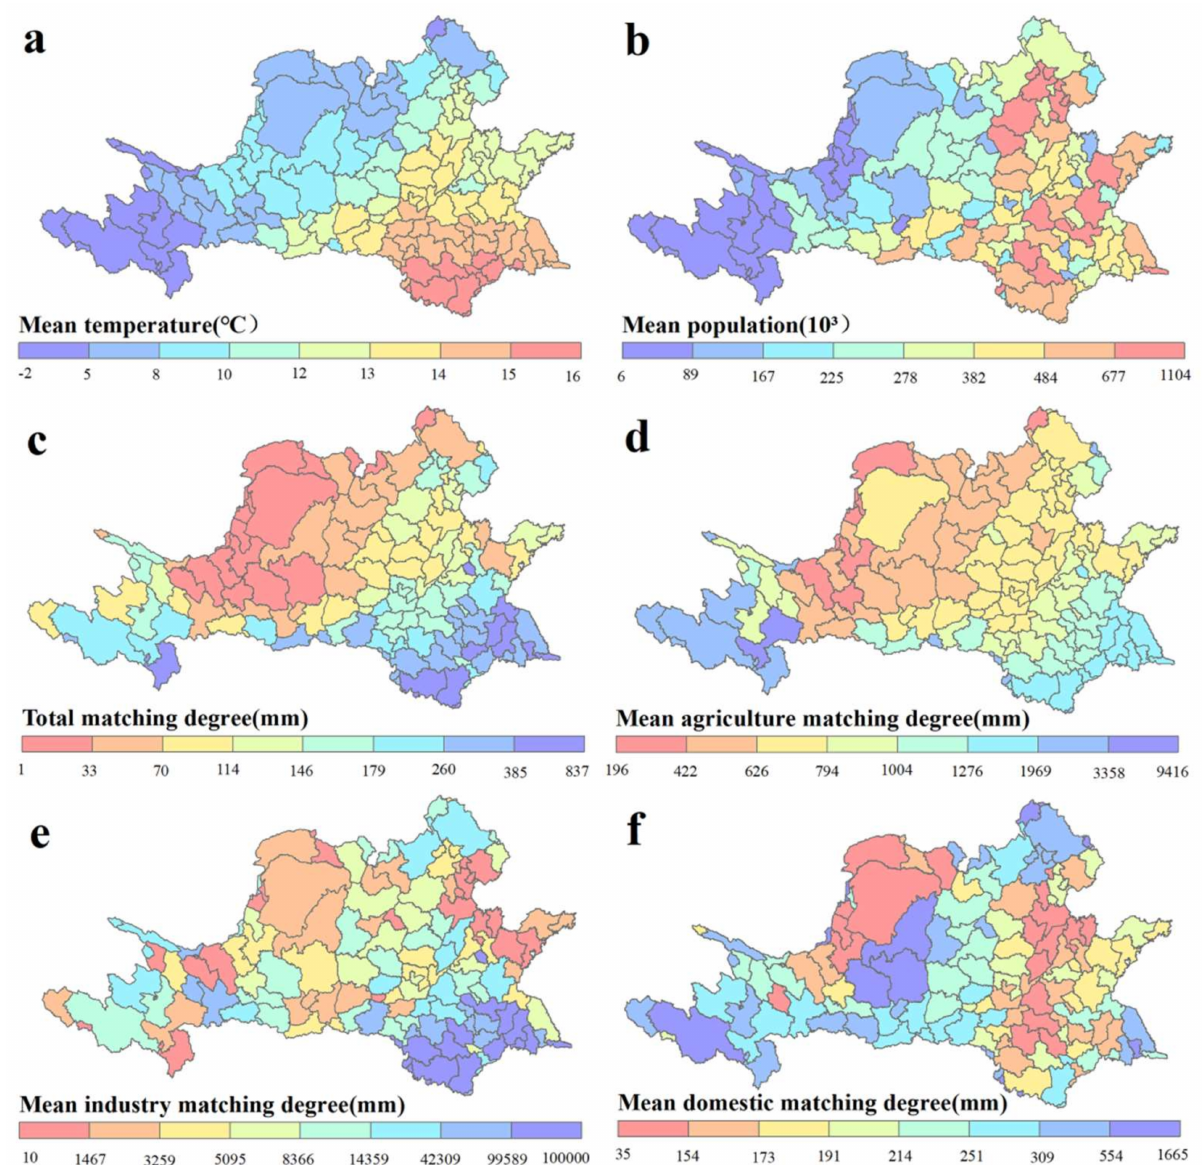
Figure 8. The spatial distributions of all relevant WLN factors for the 128 cities in the Huang-Huai- Hai River Basin from 1951 to 2017. ( a ), The spatial distribution of mean annual temperature; ( b ), The spatial distribution of mean annual population; ( c ), The spatial distribution of the mean annual total WLN matching index (Wt); ( d ), The spatial distribution of the agricultural WLN matching index (Wf); ( e ), The spatial distribution of the mean annual industrial WLN matching index (Wi); ( f ), The spatial distribution of the mean annual domestic WLN matching index